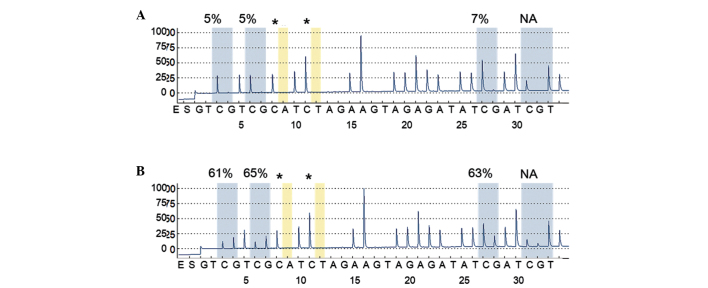
Representative examples of measurement of IRF8 methylation level using pyrosequencing. (A) Unmethylated IRF8 non-malignant lung tissue (methylation level, 6%). (B) Methylated IRF8 tumor (methylation level, 63%). The percentages are the proportion of C at each CpG site following bisulfite conversion, and the methylation level of each CpG site is estimated by the proportion of C (%). An overall IRF8 methylation level is calculated as the average of the proportion of C (%) at the three CpG sites. *Indicates no residual C at the non-CpG site, ensuring complete bisulfite conversion. IRF8, interferon regulatory factor 8; NA, not analyzed.